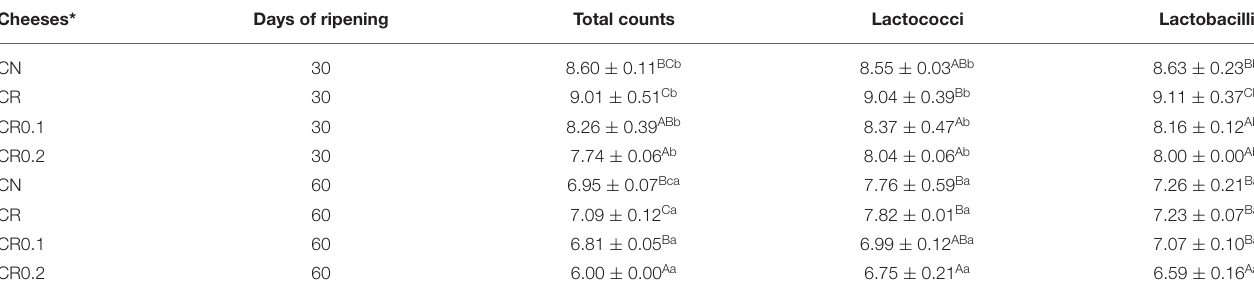
TABLE 5 | Microbiological results (log cfu g − 1 cheese) of reduced-sodium cheeses by reduced-sodium treatment (CR) at 30 and 60 days of ripening.